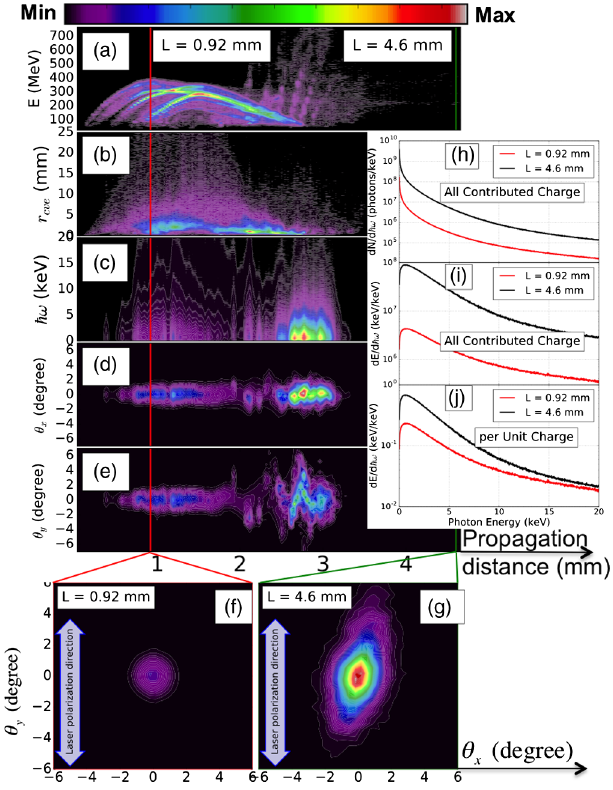
FIG. 3. Contour plots of phase space density as a function of propagation distance z of (a) electron energy (only those that contribute to the radiation emission), (b) electron radius of curvature ( r ) at point of emission, (c) photon energy (keV), cve (d) photon emission angle θ integrated over θ , and (e) photon x y emission angle θ integrated over θ . Parts (f) and (g) show the y x time integrated x-ray angular distribution at 0.92 and 4.6 mm, respectively. The time integrated x-ray spectra of all contributed charge [(h) dN = d ℏ ω and (i) dE = d ℏ ω vs ℏ ω , respectively] and per unit charge [(j) dE = d ℏ ω vs ℏ ω ] at 0.92 and 4.6 mm,